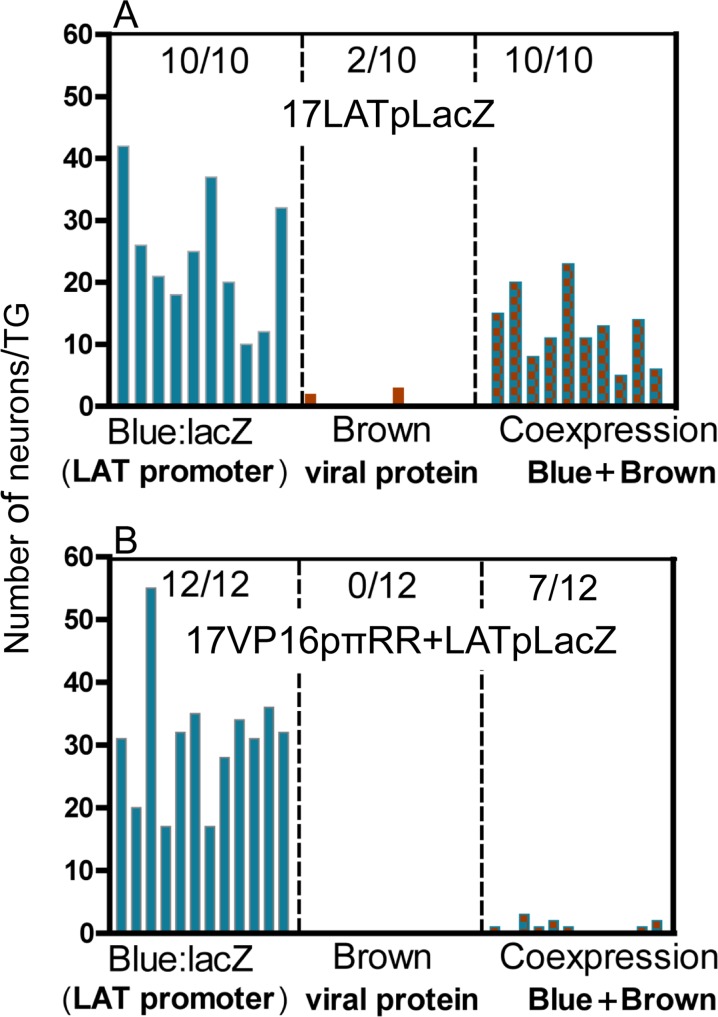
The VP16 promoter contains a region required for efficient exit from the default latent state.Mice were infected on scarified corneas with 2x105 pfu of (A) 17LATpLacZ or (B) 17VP16πRR+LATpLacZ. At 44 hrs pi TG were harvested and processed for whole ganglion histochemical detection of b-gal activity (blue) followed by immunohistochemical detection of viral proteins (brown) as detailed in methods. Each bar represents the number of positive neurons in a TG. Blue vertical bars are neurons positive for only b-gal, brown bars are those positive for only viral proteins, and blue and brown checkered bars are neurons positive for both. There were significantly more neurons containing viral proteins in 17LATpLacZ infected group, about 33% of the total labeled neurons vs. 2% of the total in the 17VP16πRR+LATpLacZ infected group (p<0.0001, Student’s t-test).